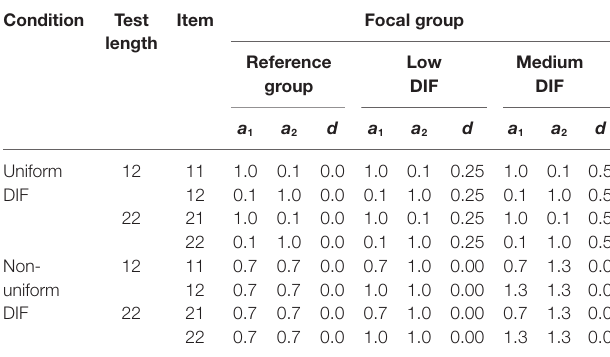
tABLe 1 | Item parameters used for generating differential item functioning (DIF) conditions in the last two items.